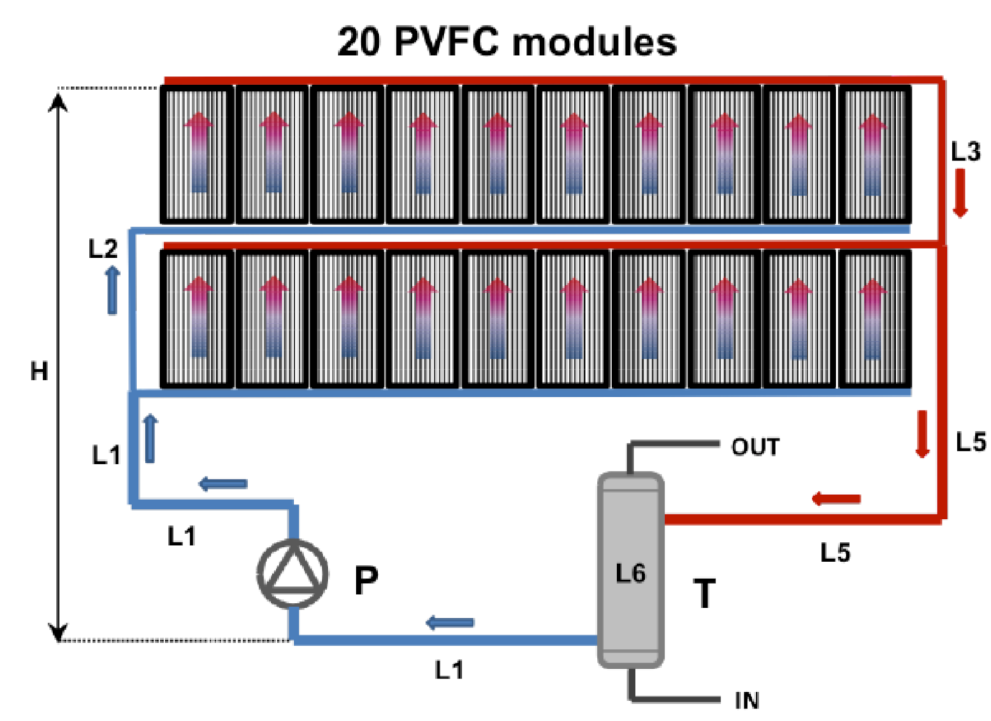
Figure 1. Layout of the PVFC plant, composed of 20 photovoltaic (PV) modules with a total